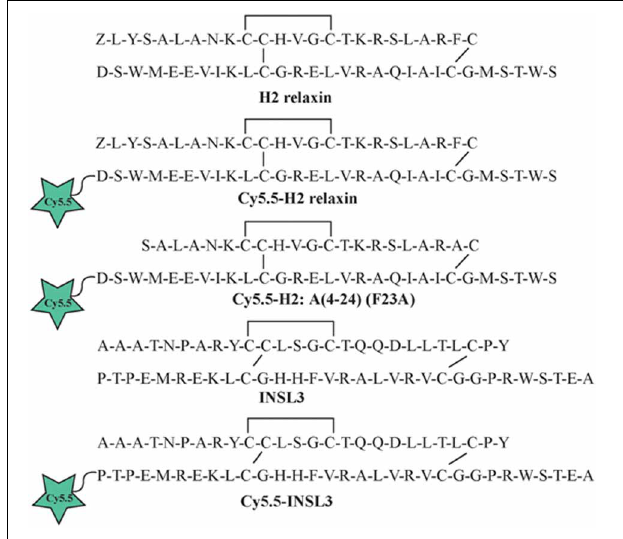
FIGURE 1 | Amino acid sequence of native H2 relaxin and INSL3 and synthetic Cy5.5